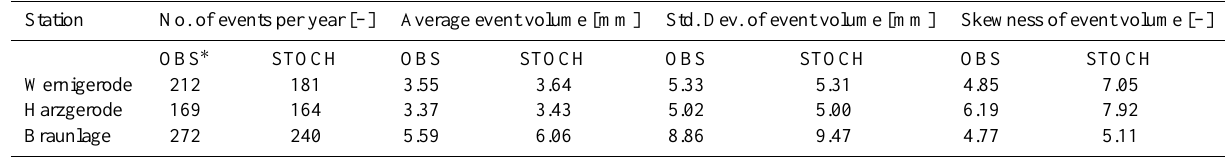
Table 2. Event characteristics for three selected rainfall stations (see Fig. 6) from 14yr observed rainfall (OBS) and 10 × 100yr stochastic generated rainfall (STOCH); OBS statistics estimated from data with missing values as